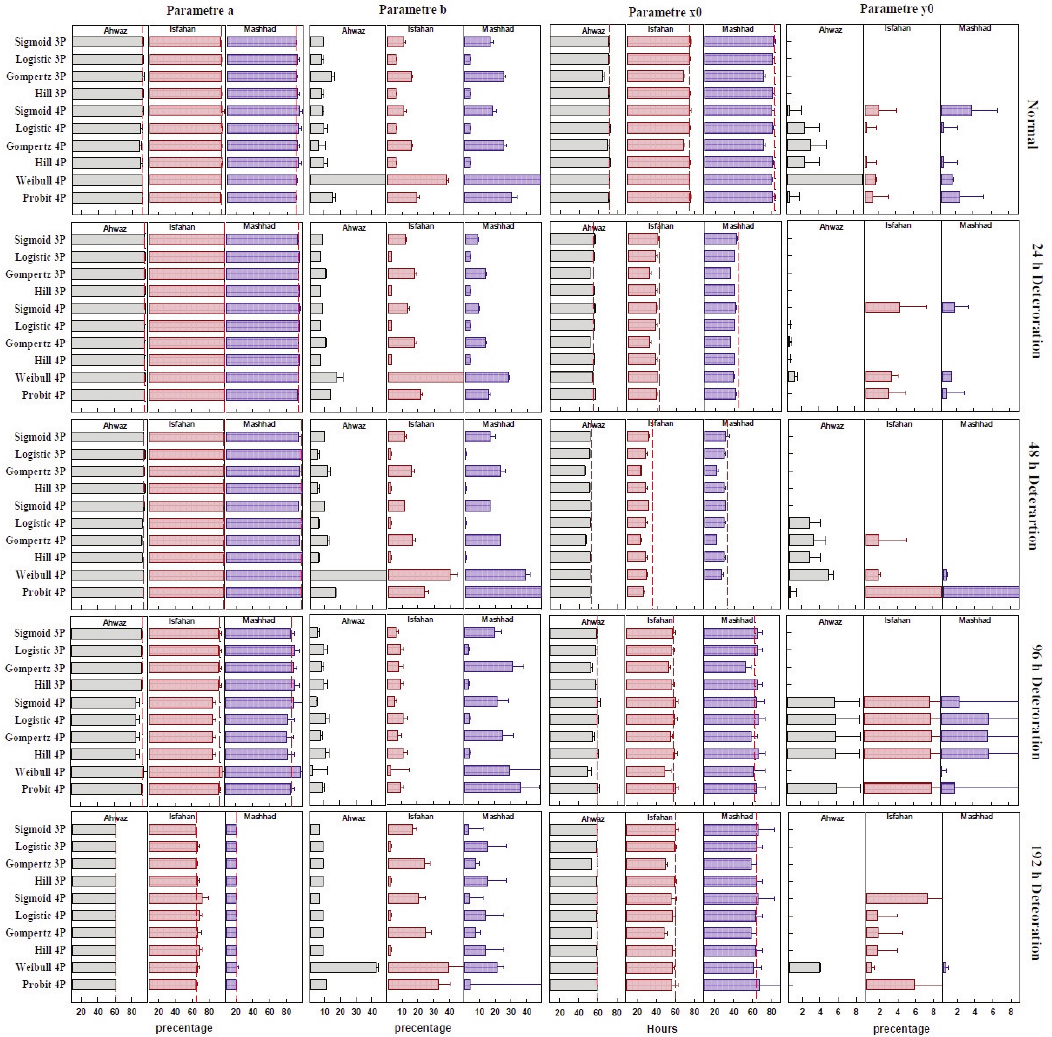
Fig. 3 - Estimate parameter of fit models germination ecotypes okra ( Abelmoschus esculentus L.) under deterioration condition. Dash red line indicated observed parameter value. Parameter a= Asymptote (theoretical maximum for y); parameter b=rate of increa- se; X0= time required to completion of germination in 50% of seed population or D50; Y0= initial seed